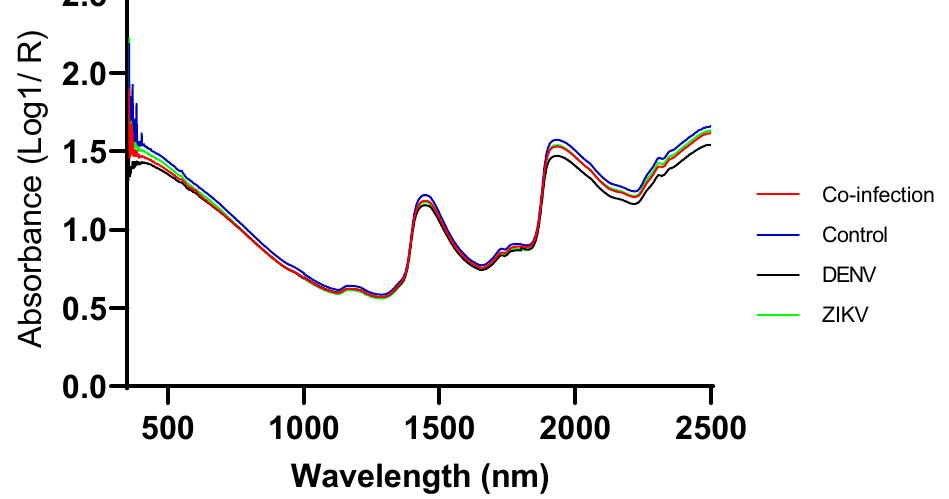
Figure 1. Average NIR spectra of Co-infected, ZIKV, DENV and uninfected mosquitoes (control) collected at 14 days post-infection by the Labspec 4i NIR spectrometer. In particular the absorbance value of uninfected mosquitoes (Blue line) was slightly higher than those of infected mosquitoes.